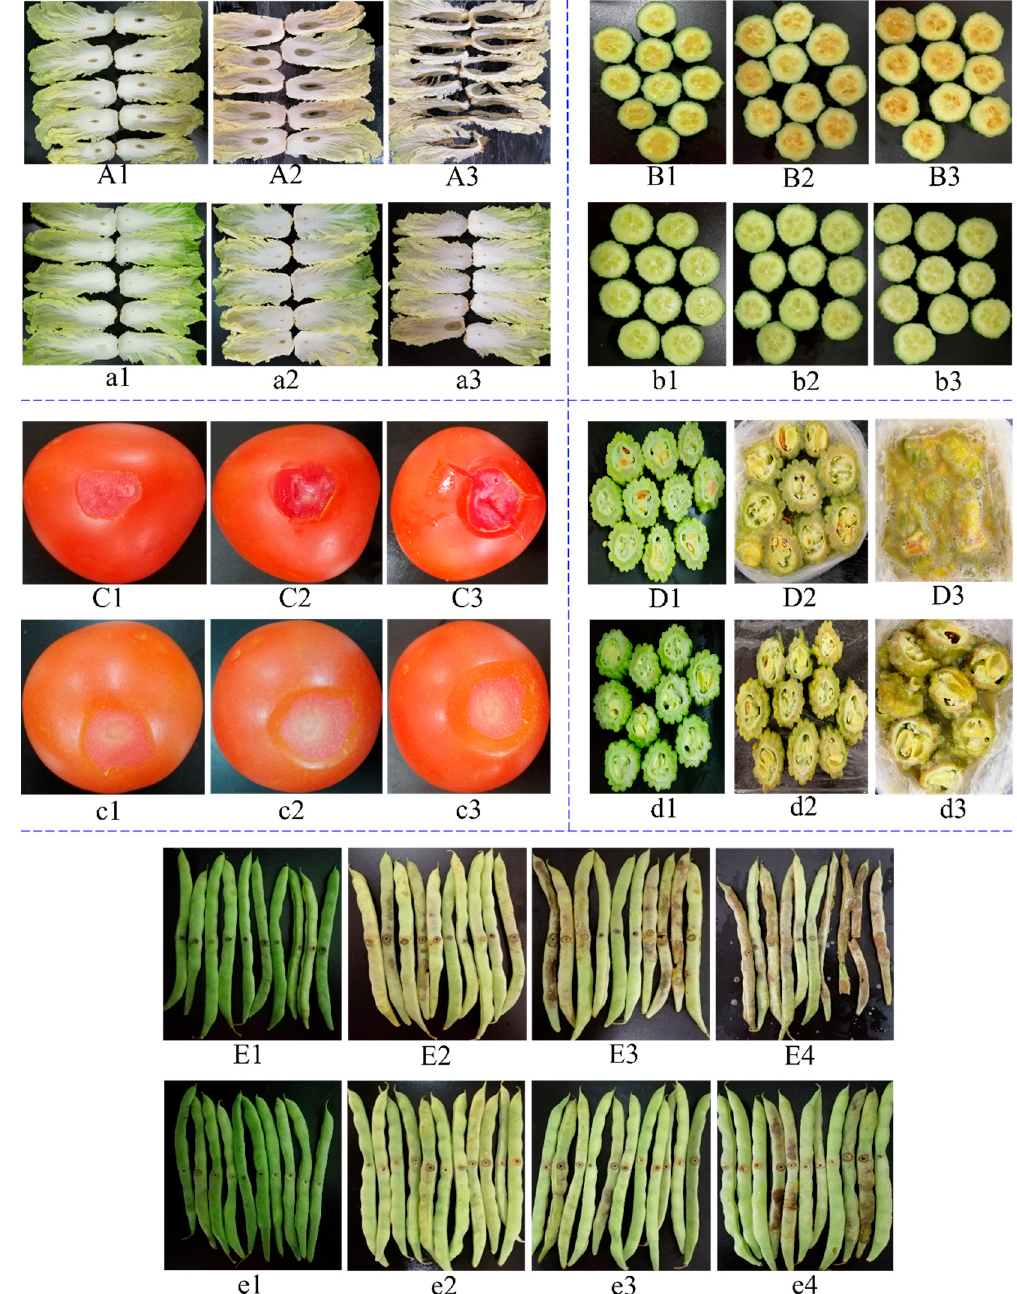
Figure 5. Controlling soft rot of vegetables. ( A , a ), Chinese cabbage; ( A1 – A3 ) are controls on 1, 2, and 3 day, respectively; ( a1 – a3 ) are treatments with bacteriocin of L. paracasei WX322 on 1, 2, and 3 day, respectively. ( B , b ), cucumber; ( B1 – B3 ) are controls on 1, 2, and 3 day, respectively; ( b1 – b3 ) are treatments with bacteriocin of L. paracasei WX322 on 1, 2, and 3 day, respectively. ( C ) and ( c ), tomato; C1, C2, and C3 are controls on 1, 2, and 3 day, respectively; ( c1 – c3 ) are treatments with bacteriocin of L. paracasei WX322 on 1, 2, and 3 day, respectively. ( D , d ), balsam pear; ( D1 – D3 ) are controls on 1, 2, and 3 day, respectively; ( d1 – d3 ) are treatments with bacteriocin of L. paracasei WX322 on 1, 2, and 3 day, respectively. ( E , e ), green bean; ( E1 – E4 ) are controls on 1, 2, 3, and 4 day, respectively; ( e1 – e4 ) are treatments with bacteriocin of L. paracasei WX322 on 1, 2, 3, and 4 day, respectively.